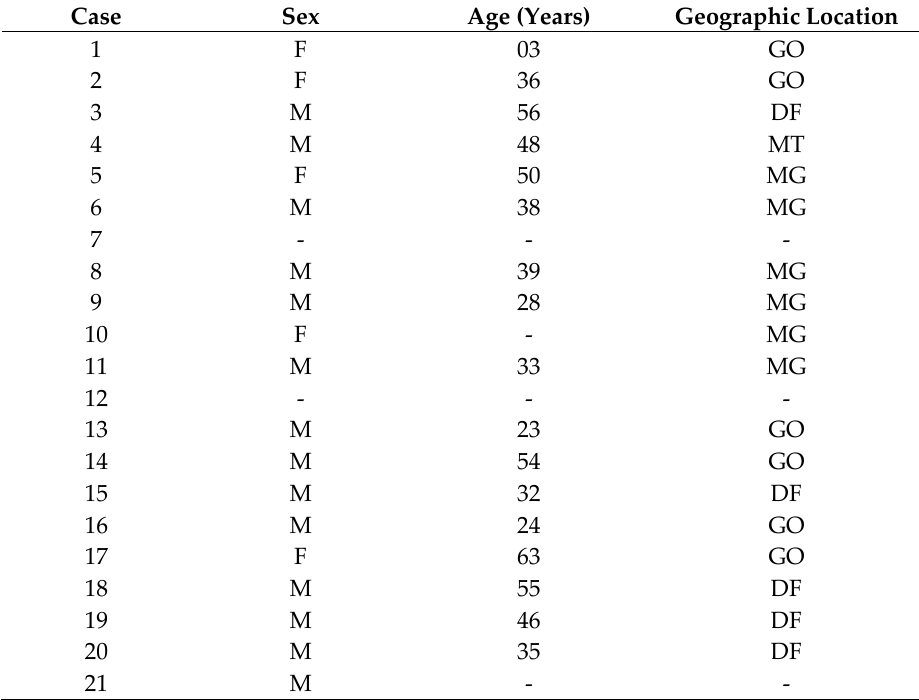
Table 1. Characteristics demographic of 21 Brazilian yellow fever patients. Case Sex Age (Years) Geographic